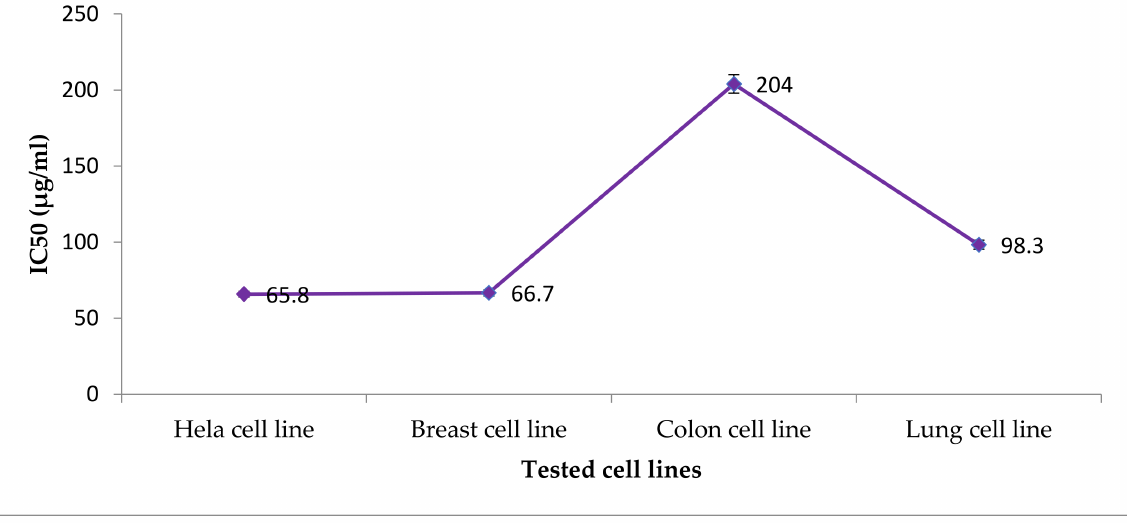
Figure 3. Antitumor (as IC 50 ) of tested extract (0.44 mg/L Zn of Nostoc linckia) against four cancer cell lines. Figure 4 represents the percentage of anticancer activity of fractions (1, 6, 7 and 8) against cell line (Hela cell line). The IC 50 ( µ g/mL) of fractions (1, 6, 7 and 8) was 195.3, 258.9, 357.1 and 195.3 µ g/mL,